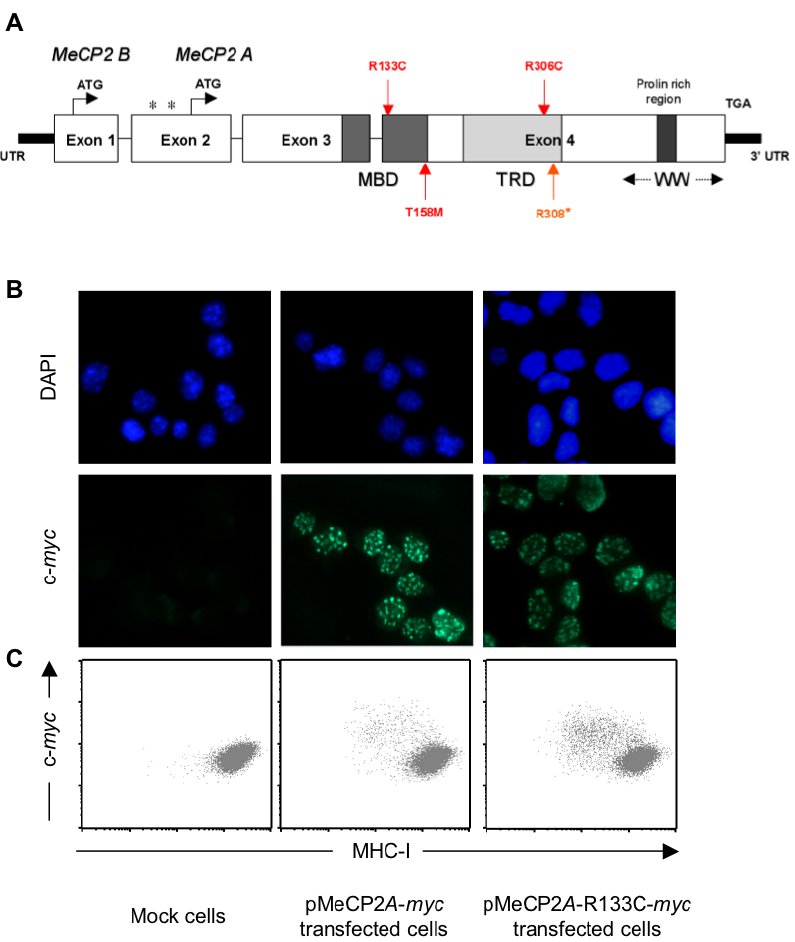
Figure 3. Mutant forms of MeCP2 that cause RTT retain their repressive effect on MHC class I expression. Panel A: Schematic representation of the MeCP2 protein. Red and orange arrows indicate the positions of the mutations introduced in MeCP2 by site-directed mutagenesis (MBD: methyl-CpG binding domain, TRD: transcription repression domain, WW: group II WW-domain-binding region). Panel B: N2A cells transfected with empty pcDNA3.1 (mock cells), with pcDNA3.1 expressing Myc-tagged MeCP2 A (pMeCP2 A - myc ) or with pcDNA3.1 expressing Myc-tagged MeCP2 A with the R133C point mutation (pMeCP2 A -R133C- myc ) were stained with mouse anti-Myc 9E10 monoclonal antibody, and FITC-labelled anti-mouse IgG antibody. Coverslips were mounted in DAPI-containing ProLong Gold antifade reagent (Molecular Probes) before observation by fluorescence microscopy. Panel C: N2A cells transfected as in panel B were double immunostained for cell surface MHC class I and intracellular Myc-tagged MeCP2, then analysed by flow cytometry. Similar data were obtained for all four mutated forms of MeCP2 A and MeCP2 B (not shown), and these observations were reproduced in three independent transfection experiments.